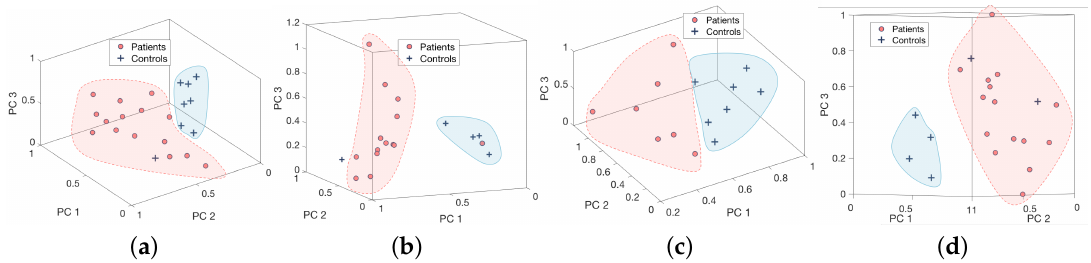
Figure 9. Principal component description of the four movement routines (( a ) pouring, ( b ) pointing, ( c ) walking, and ( d ) walking around a chair) from Sensor 2 and